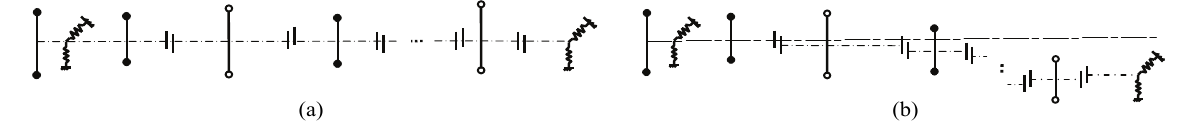
Fig. 1. Schematic diagrams of a misaligned rotor with (a) local offset, and (b) global offset; • : unbalanced mass, ||: coupler. was usually no differentiation between local and global coupler offset. The authors intend to model and discuss these differences in this article. The local coupler misalignment can be treated as an eccentricity between coupler’s two disks as Fig. 1(a) shows. The global offset is yet shown in Fig. 1(b). The difference between them is